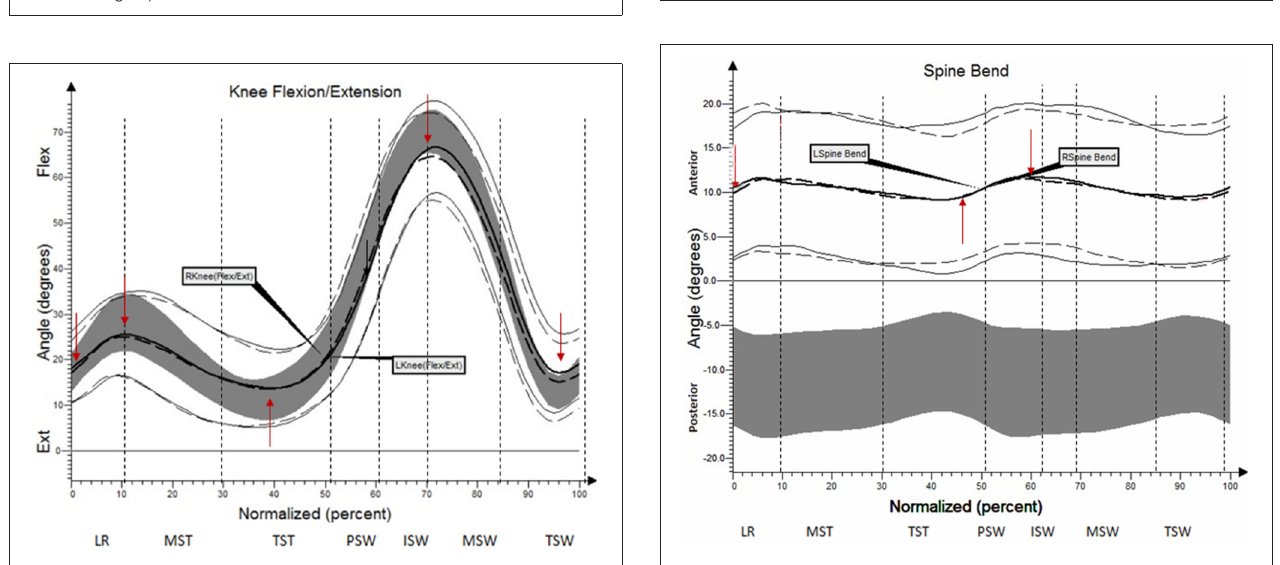
FIGURE 2 | Angular changes in the ankle-shin joint HD study group compared with control group.